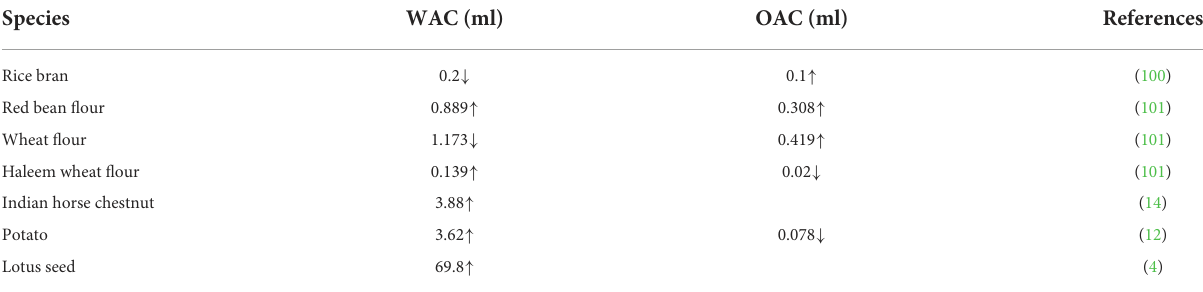
TABLE 6 Effect of microwave treatment on water absorption and oil absorption capacity of protein in food.